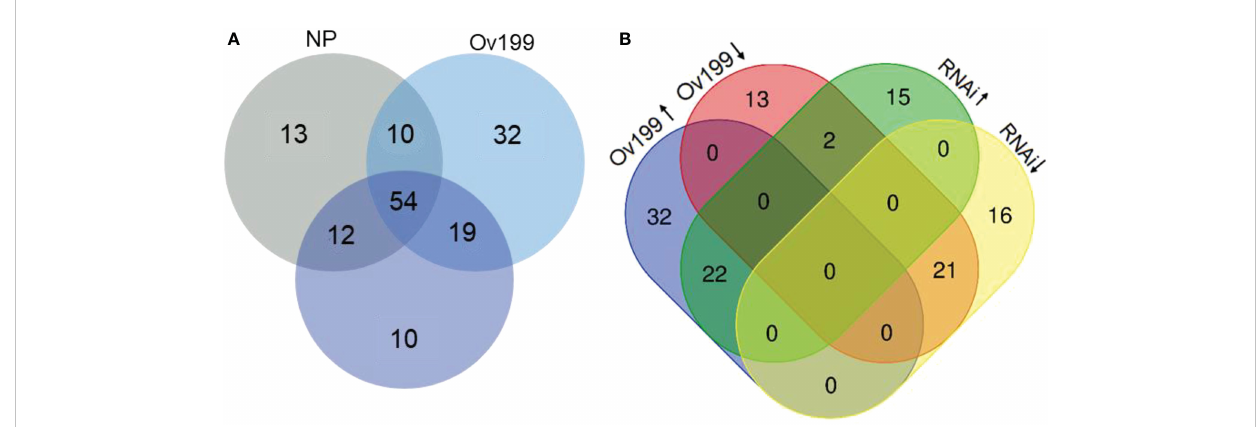
FIGURE 6 Analysis of signi fi cant difference novel miRNA between NP, Ov199 and RNAi. (A) Venn diagram of unique and shared miRNA in NP, Ov199 and RNAi. (B) Venn diagram of unique and shared miRNA with signi fi cant difference expression between upregulated and downregulated miRNA in Ov199 and RNAi compared with